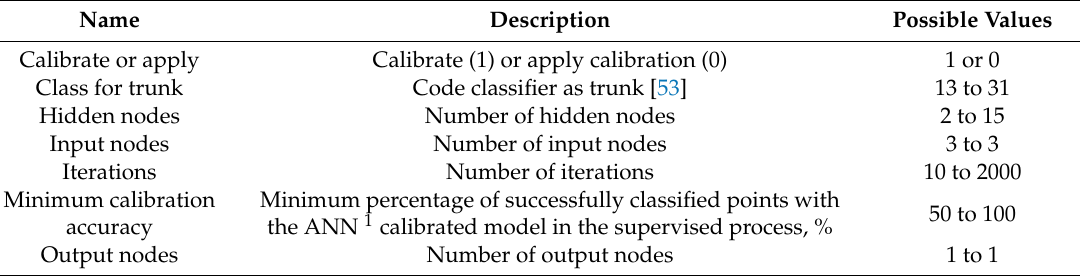
Table 3. List of the editable parameters of the point cloud classifier.